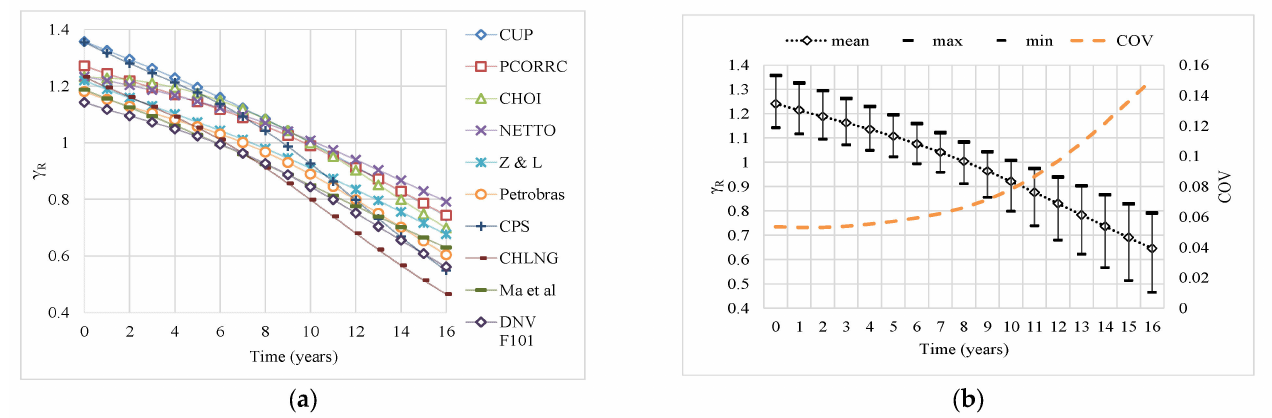
Figure 3. ( a ) PSF ( γ R ) for low-grade steel as a function of elapsed life and ( b ) mean, range and uncertainty of PSF.